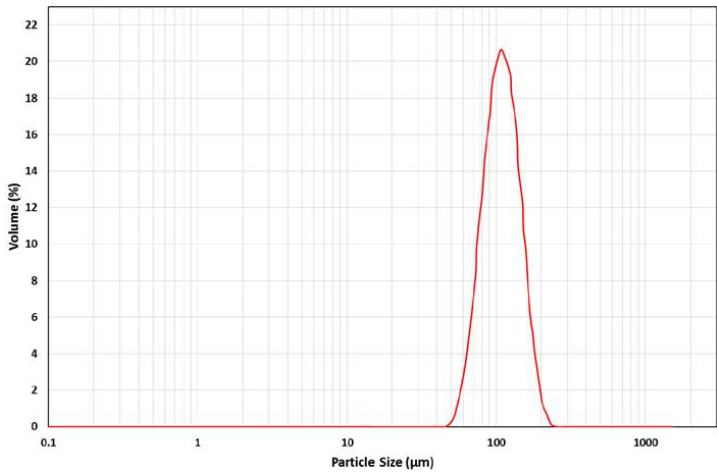
Figure 1. Particle size distribution of the feedstock powder.